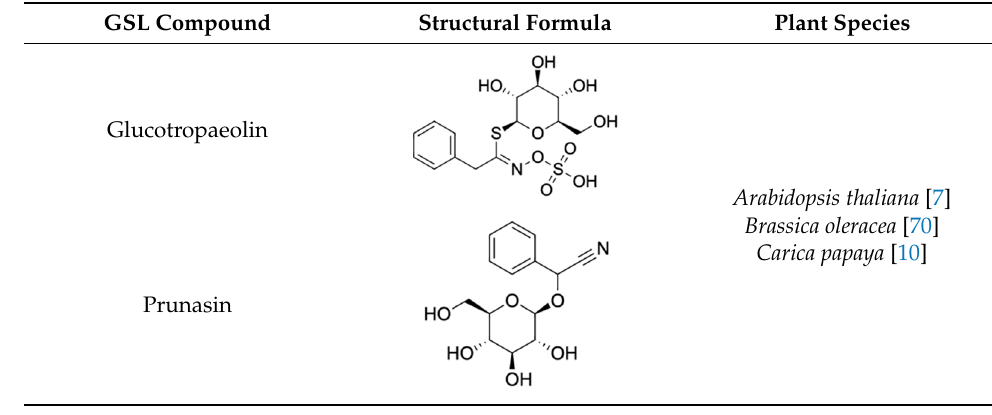
Table 1. Glucotropaeolin and prunasin in Brassica and papaya.